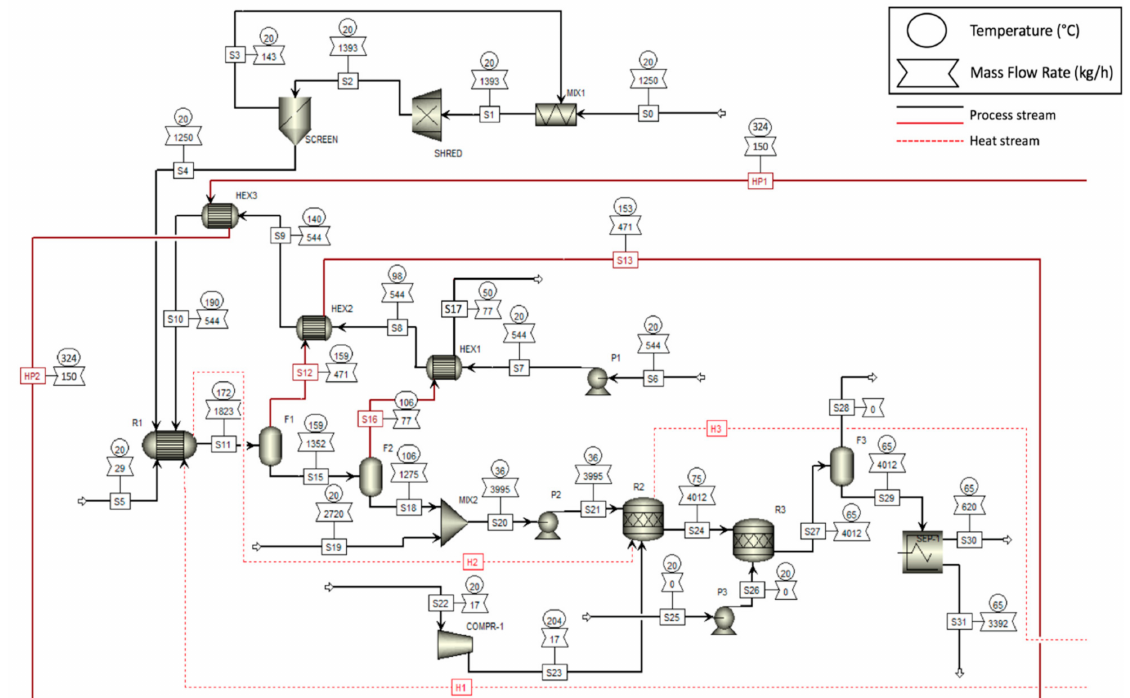
Figure 1. Flowsheet of feed handling and steam explosion pre-treatment as simulated using Aspen